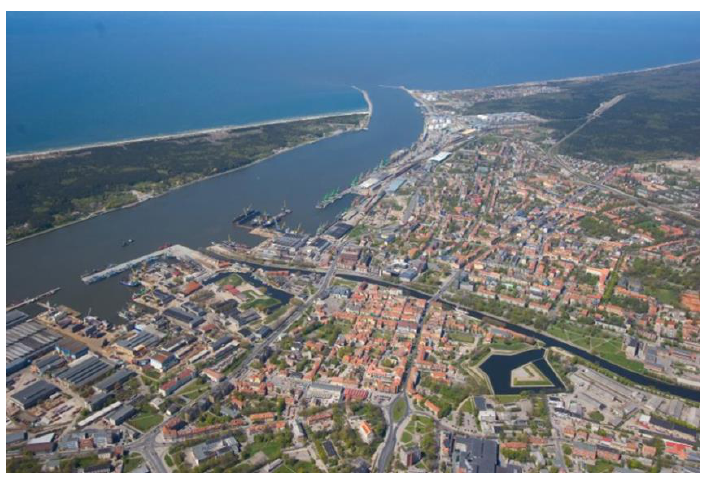
Figure 3. Klaipeda seaport. Source: [63].